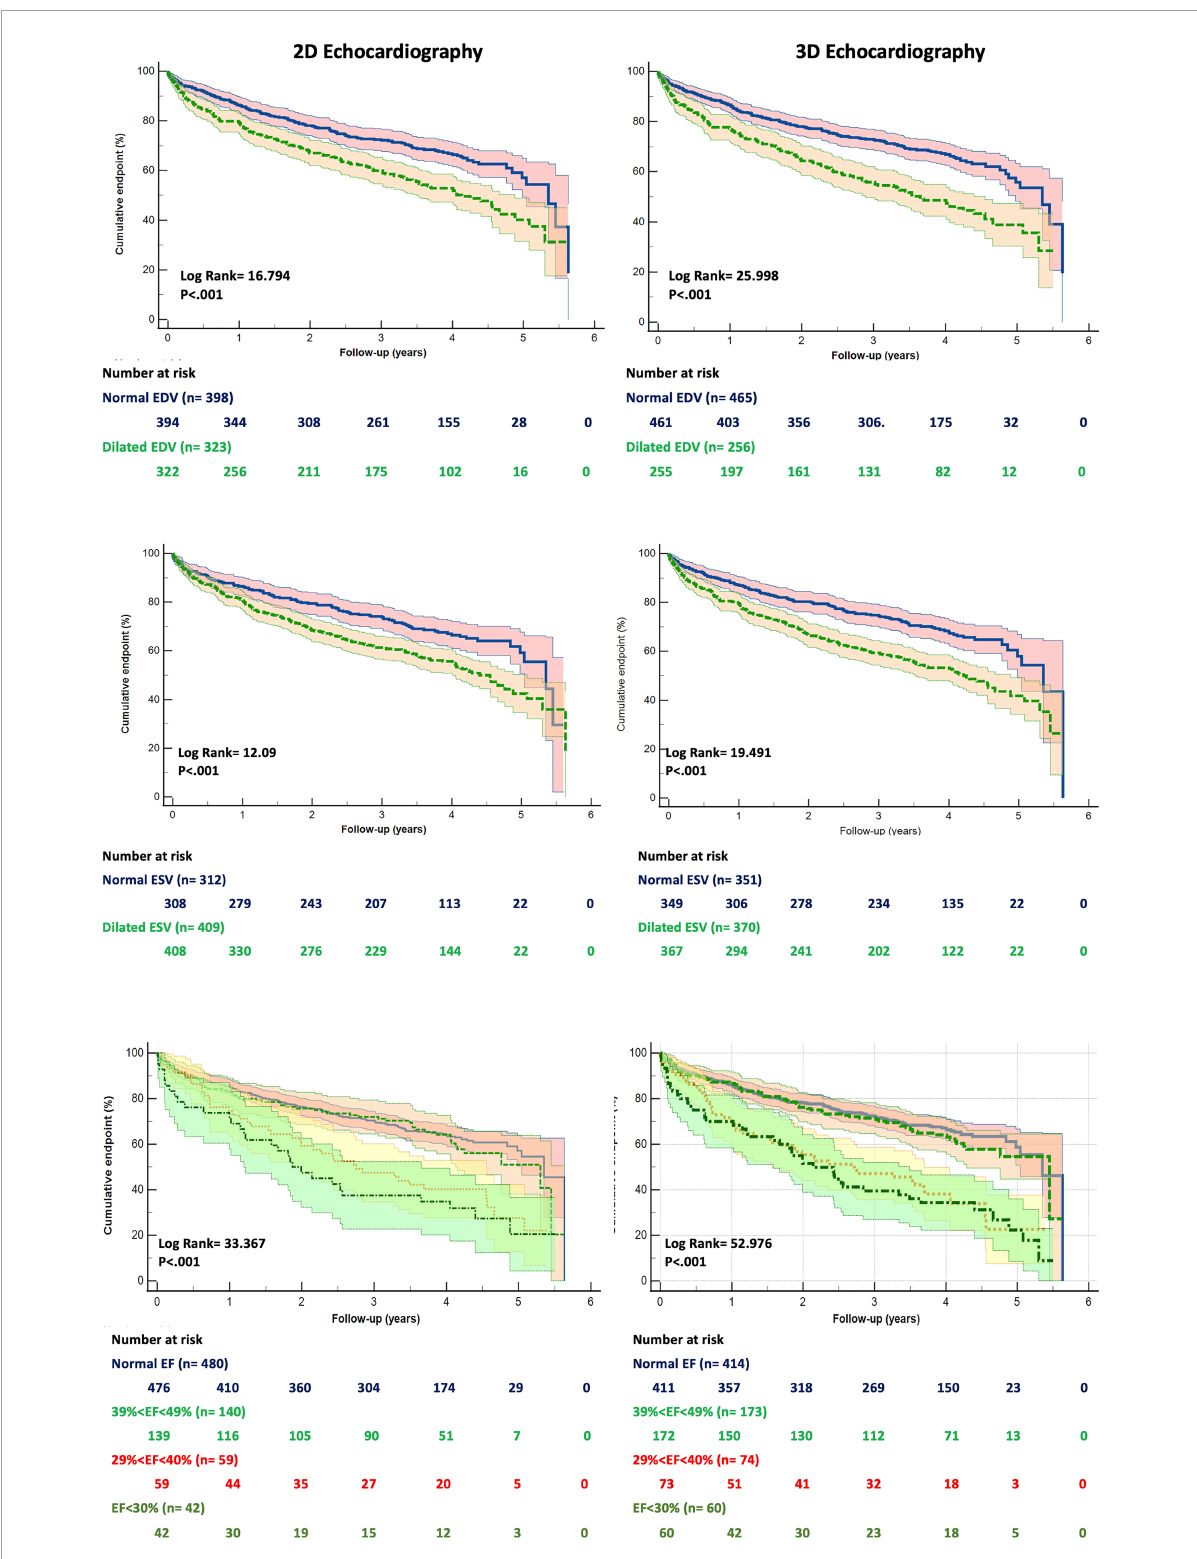
FIGURE4 Kaplan Meyers curves for freedom from the cumulative event of death and cardiac hospitalization for dilated left ventricular end-diastolic (upper panels) , end-systolic (mid panels) volumes and reduced ejection fraction (bottom panels) obtained by two- (left panels) and three-dimensional (right panels) echocardiography, respectively. Abbreviations as in Figure 1